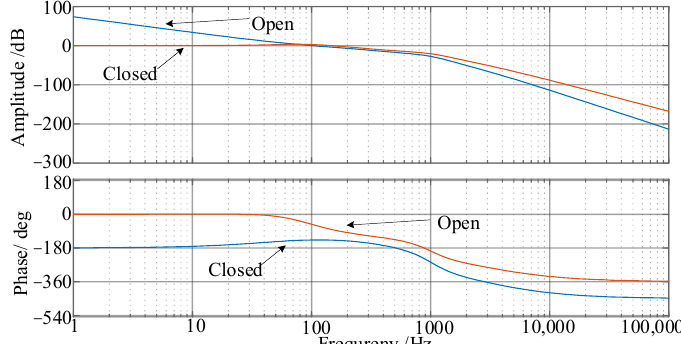
Figure 15. Bode plot of speed open loop and closed loop.